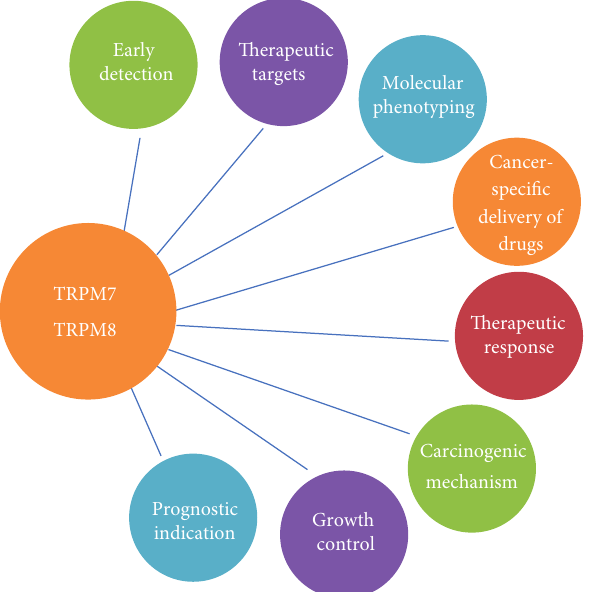
F 5: A schematic diagram to illustrate the diverse roles of TRPM7 and TRPM8 channels as potential clinical biomarkers and therapeutic targets in pancreatic adenocarcinoma, and also as growth and migratory regulators in normal exocrine pancreas and in malignant neoplasia of pancreas. e various roles of TRPM7 and TRPM8 are likely applicable to other malignant tumors that exhibit aberrant expression and/or activities of TRPM7 and